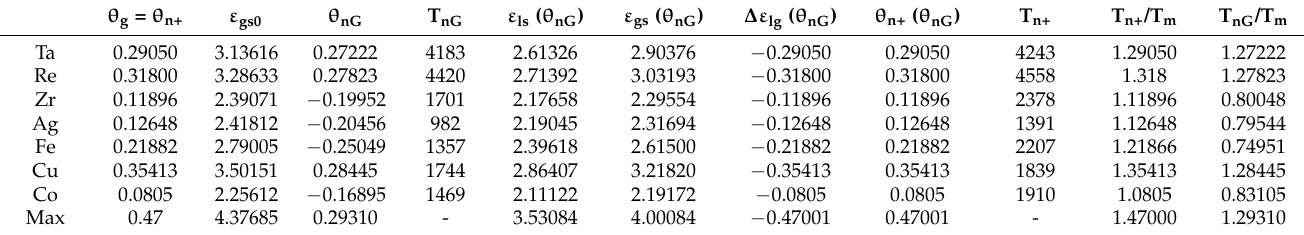
Table 2. Examples of second melting temperatures T n+ and nucleation temperatures T nG of glacial phases of Tantalum, Rhenium, Zirconium, Silver, Iron, Copper and Cobalt above T m . For θ g = θ n+ equal to singular values of enthalpy coefficients; ε gs0 deduced from Equation (8) with ∆ ε = 0; θ nG the reduced nucleation temperature of glacial phase leading to ∆ ε − ε gs ( θ − θ n+ ; ε θ ε θ θ ε gs ( θ nG ) = nG ) nG ) = nG ) and nG ) deduced from Equations (4) and (5); temperatures T n+ in lg ( ls ( ls ( Kelvin; ratios T n+ /T m and T nG /T m